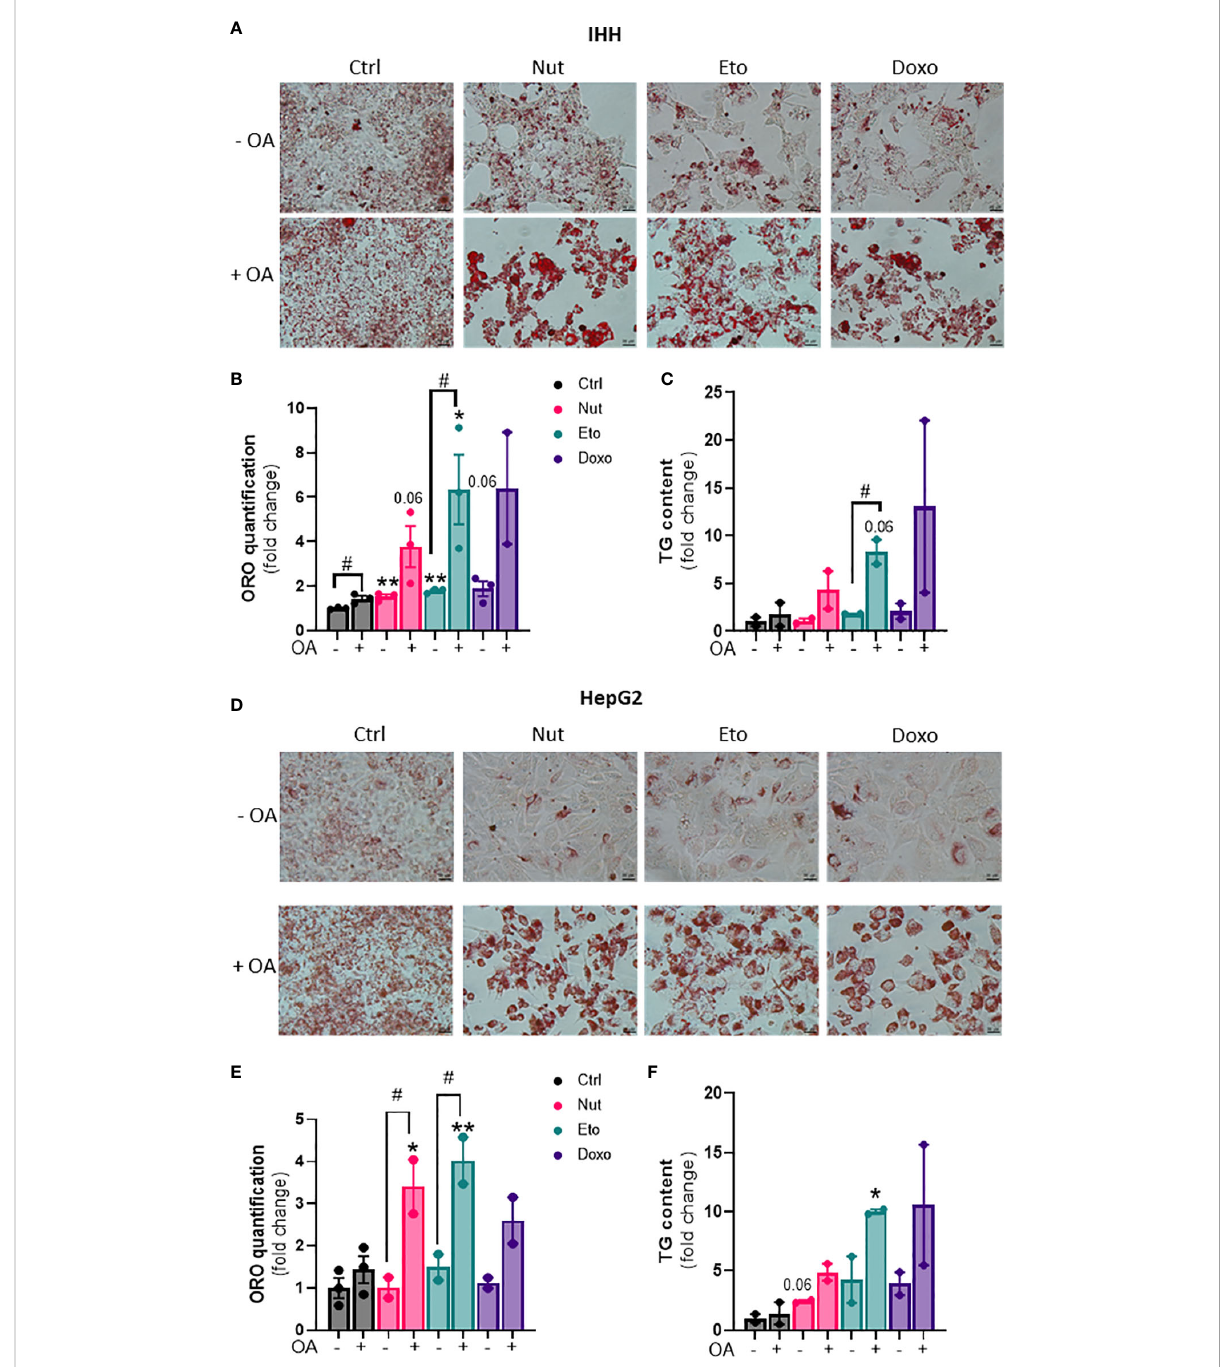
FIGURE 2 Increased steatosis in senescent human hepatocytes. Human hepatocytes were treated with nutlin (Nut; 3 µM), etoposide (Eto; 20 µM) and doxorubicin (Doxo; 0,2 µM) for 5 days, with or without the addition of oleic acid (OA) for another 24h. Oil Red O (ORO) staining (A, D) , ORO quanti fi cation (B, E) and triglyceride (TG) content (C, F) in IHH and HepG2 hepatocytes. Scale bars represent 25 µm. ORO quanti fi cation and TG levels were normalized to cell number with DAPI staining. Results are expressed as Mean ± SEM. *P < 0.05, **P < 0.01 indicates a signi fi cant difference compared to control cells. # P < 0.05 indicates a signi fi cant difference compared to similar treatment condition without